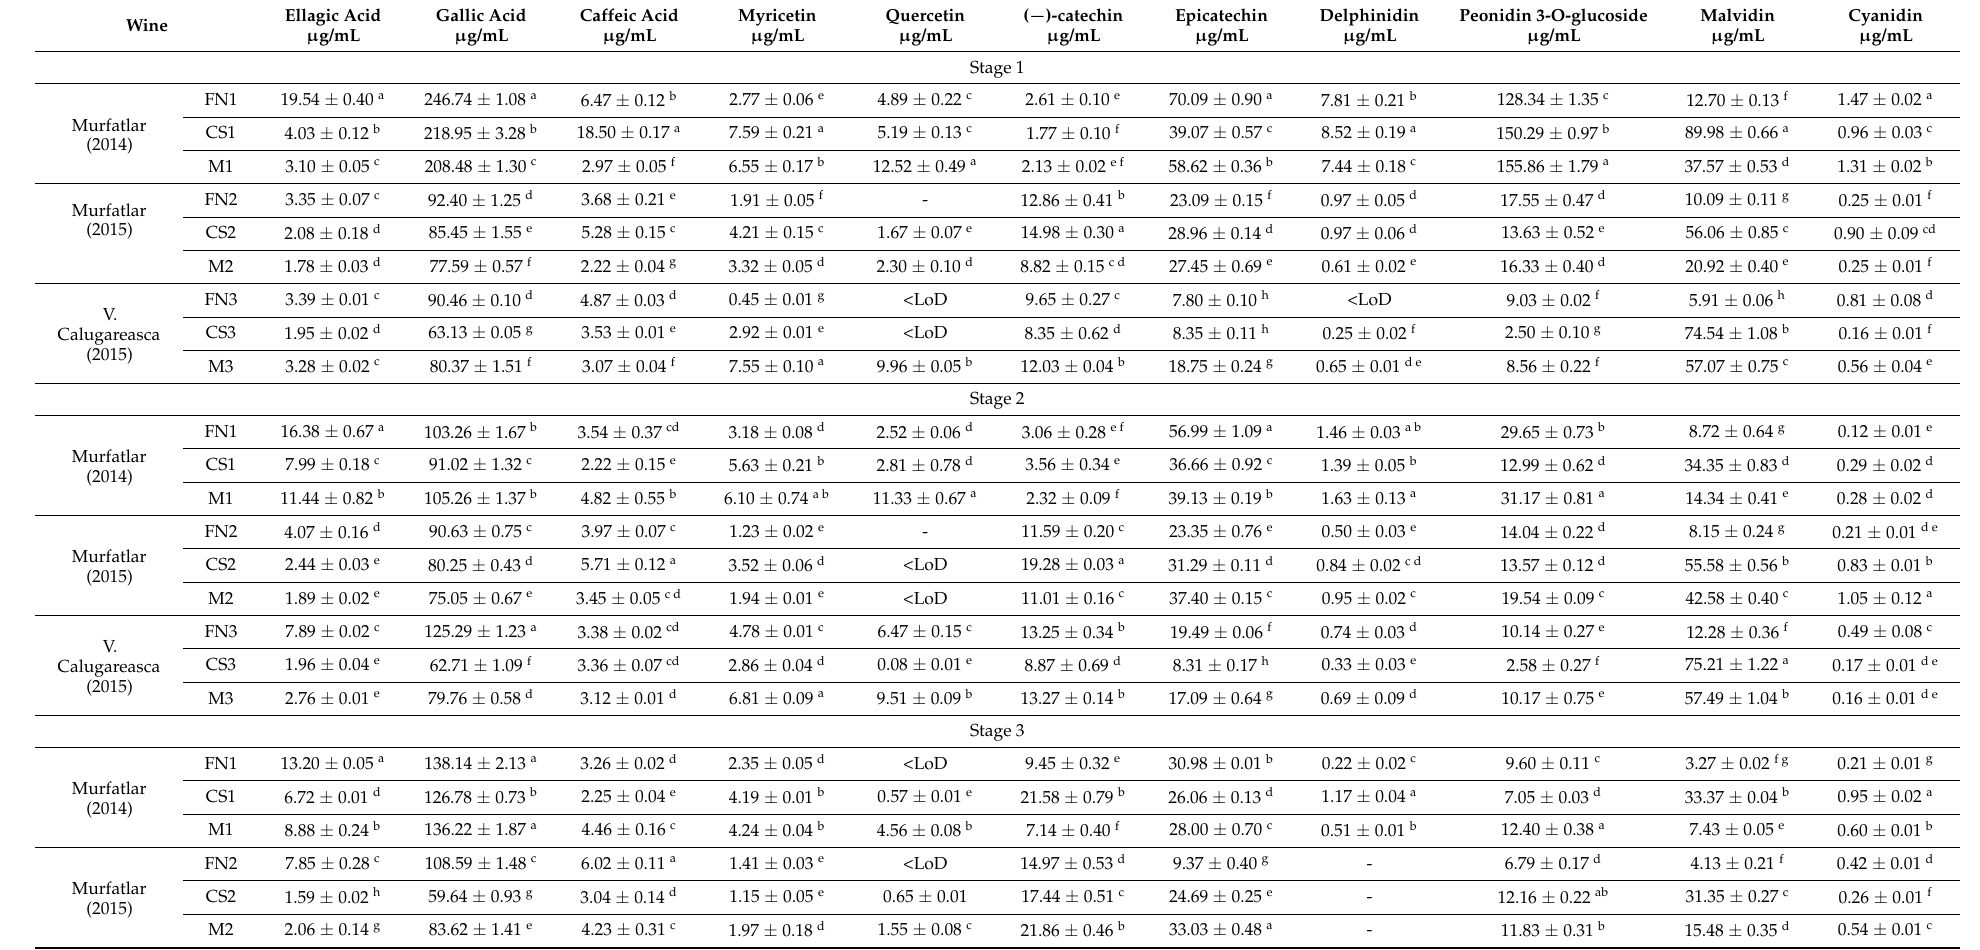
Table 1. Polyphenolic profile of wines from Murfatlar (2014), Murfatlar (2015), and Valea Calugareasca